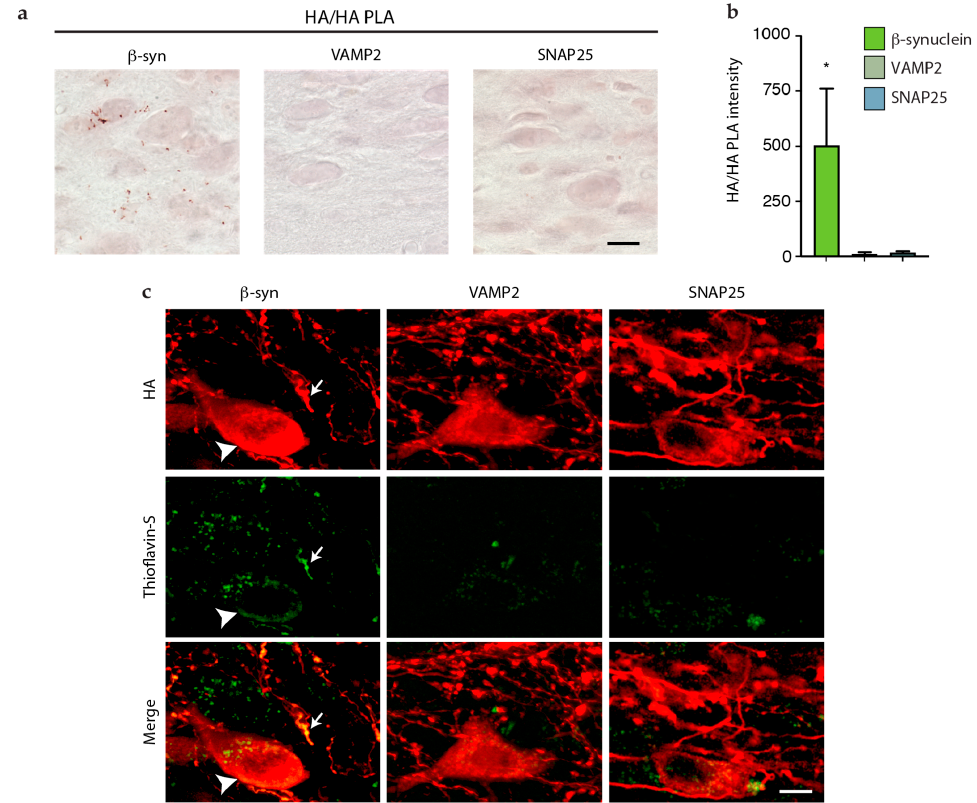
Figure 5. Aggregation of β -syn but not VAMP2 and SNAP25 in dMO. Mice received an injection of AAV- β -syn-HA, AAV-VAMP2-HA, or AAV-SNAP25-HA into the left vagus nerve and were sacrificed 6 weeks after surgery. Coronal sections of the medulla oblongata were processed for HA/HA PLA and HA/Thioflavin-S co-staining. ( a ) Representative images show specific PLA labeling (reddish brown) only in the DMnX of mice treated with AAV- β -syn-HA. Scale bar: 10 μ m. ( b ) Image analyses were carried out in the left (ipsilateral to AAV injections) dMO and measured the intensity of the PLA signal. Data are expressed as arbitrary units. ANOVA, F 2,11 = 4.79, * p < 0.05. ( c ) Representative images show Thioflavin-S labeling (green) within HA-immunoreactive neurites (arrow) and cell bodies (arrowhead) in the DMnX of mice treated with AAV- β -syn-HA but not AAV-VAMP2-HA or AAV-SNAP25-HA. Scale bar: 10 μ m.